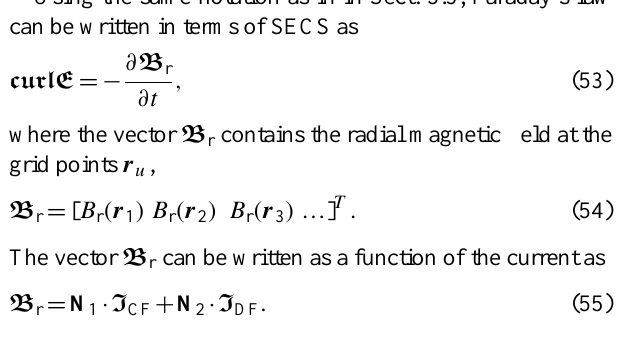
and/or when Hall conductance is large. Later studies by